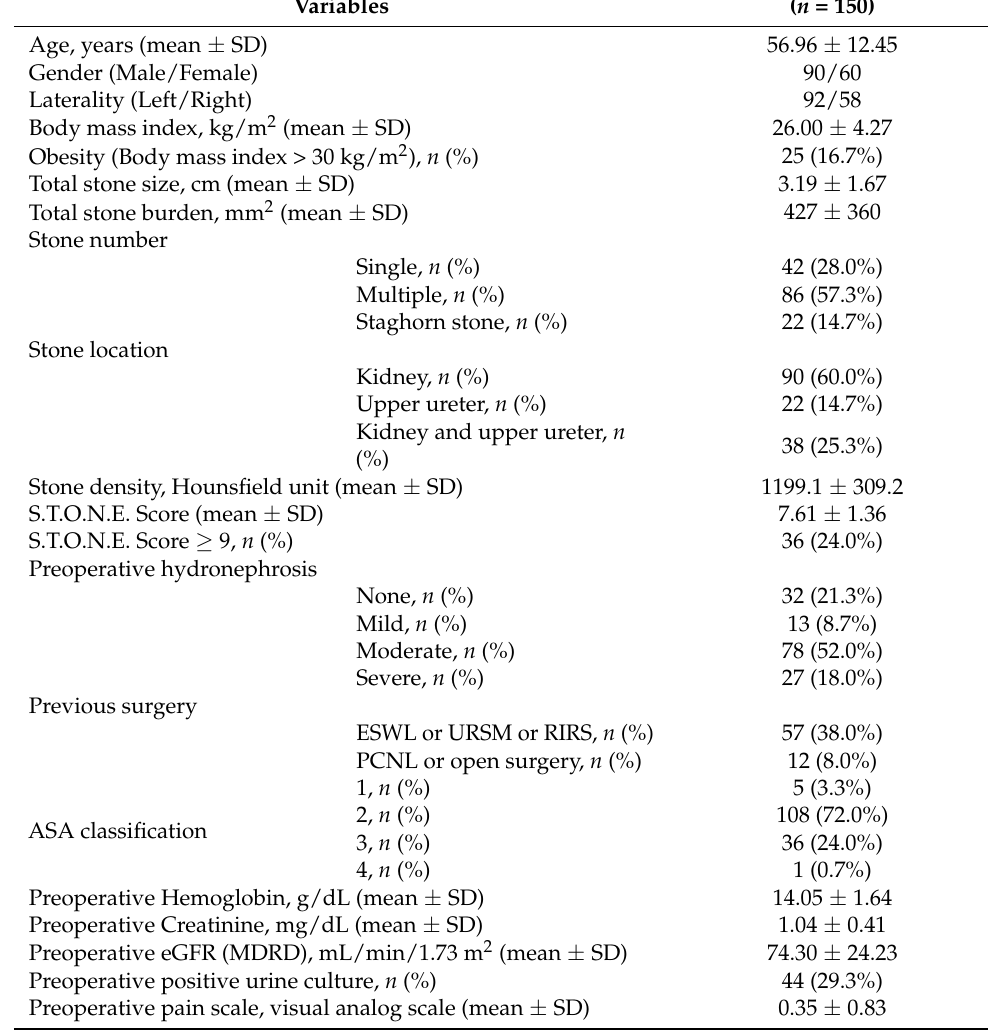
Table 1. Patients’ characteristics.